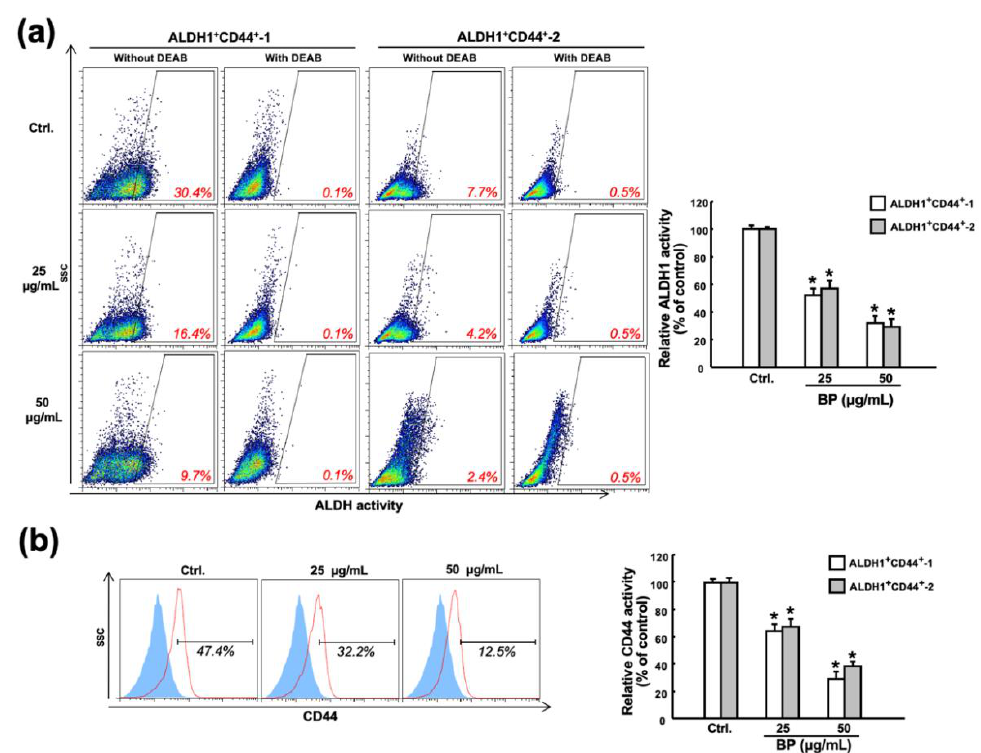
Figure 2. Butylidenephthalide suppresses the expression of CSC markers in two patient-derived ALDH1 + /CD44 + cells. ( a ) Flow cytometry analyses of two patient-derived ALDH1 + /CD44 + cells treated with various concentrations of butylidenephthalide for 48 h followed by incubation with ALDEFLUOR kit (to measure an ALDH1 enzymatic activity) in the presence of 4-diethylaminobenzaldehyde (DEAB, a specific ALDH1 inhibitor) as a control or ( b ) anti-CD44 antibody. Results are presented as means ± SD of three independent experiments; * p < 0.05 compared to Ctrl (control group containing 0.1% DMSO without butylidenephthalide). Butylidenephthalide (BP).